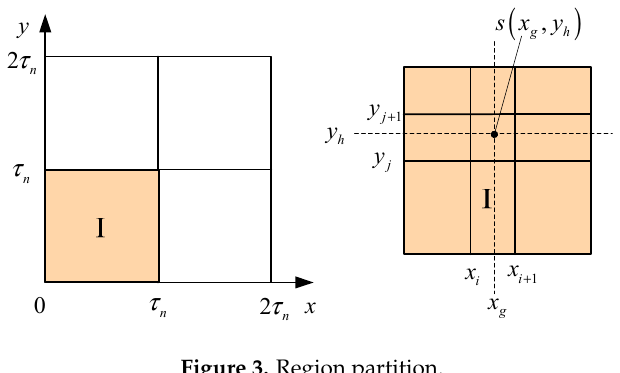
Figure 3. Region Figure 3. Region partition.